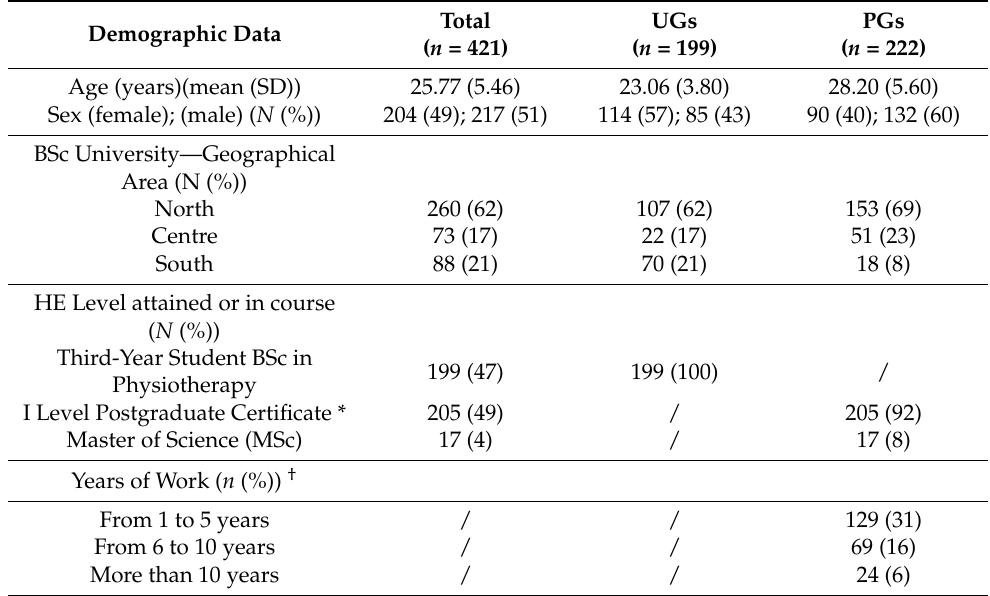
Table 2. Participants’ demographic